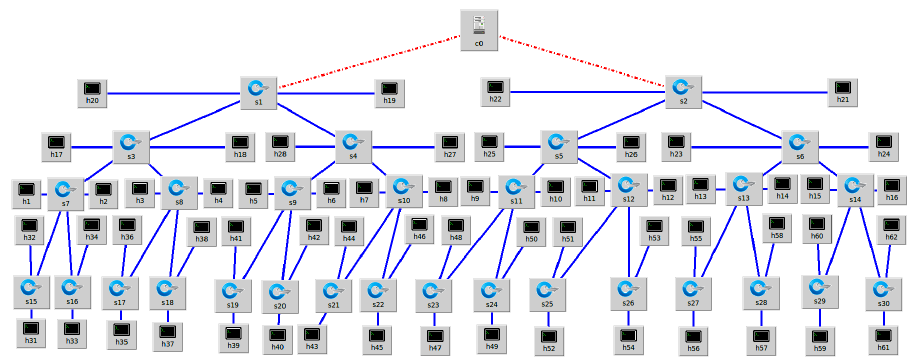
Figure 3. Custom SDN-enabled IoT network topology with floodlight